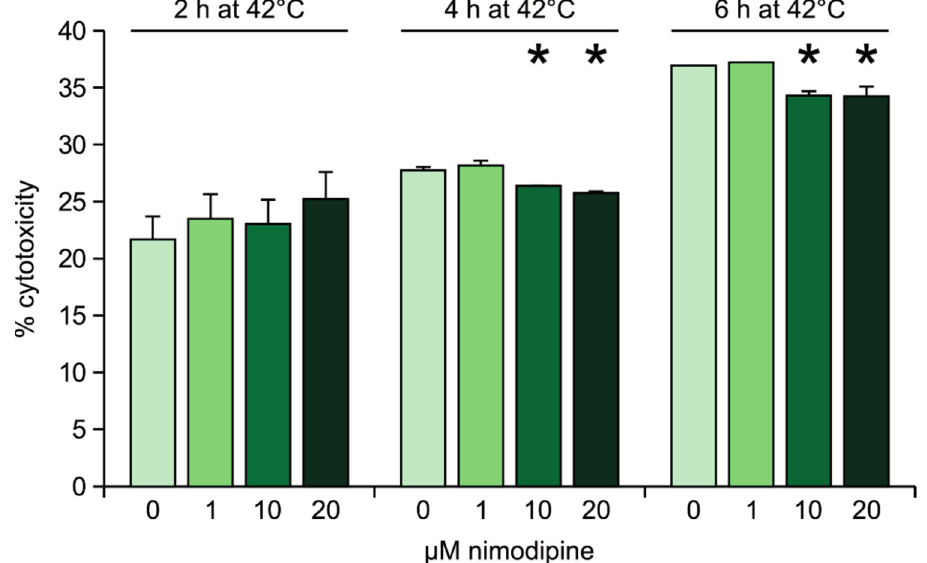
Figure 2. Lactate dehydrogenase (LDH) measurement after heat stress. Values are given as the mean ± SD (error bars) of one representative out of at least three biologically independent experiments. Nim: nimodipine; single asterisk: p ≤ 0.05 compared to non-treated cells.